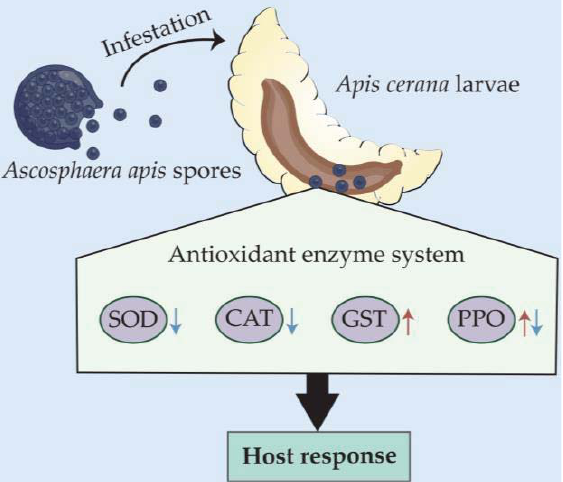
Figure 7. A hypothetical schematic diagram of the effect of A. apis infestation on the activities of four antioxidant enzymes in A. cerana larval guts.